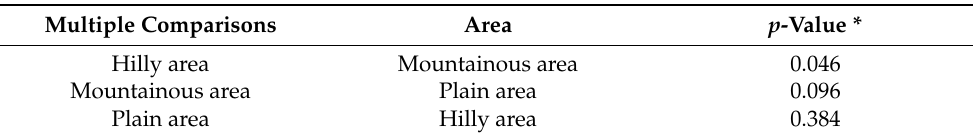
Table 6. Significance of multiple comparisons (by ANOVA) for regulating service perceptions in three topographic